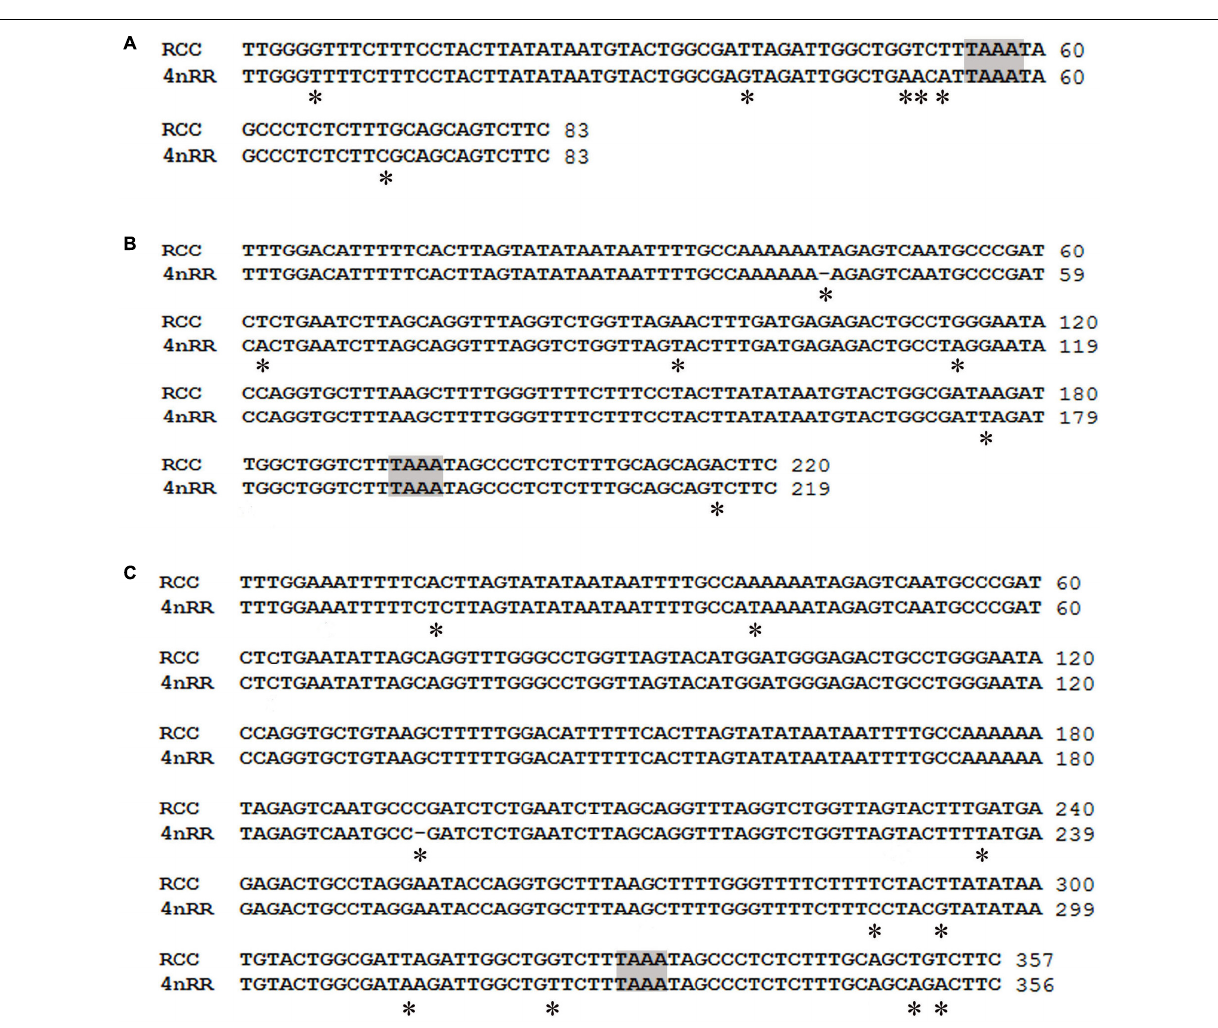
the primers 5S NT1- 5S NT2R. Using these primers, the PCR yielded a single band of 352 bp in 4 n RR, but no band in RCC and 4 n RB ( Figure 5 ). Sequence analysis revealed that this